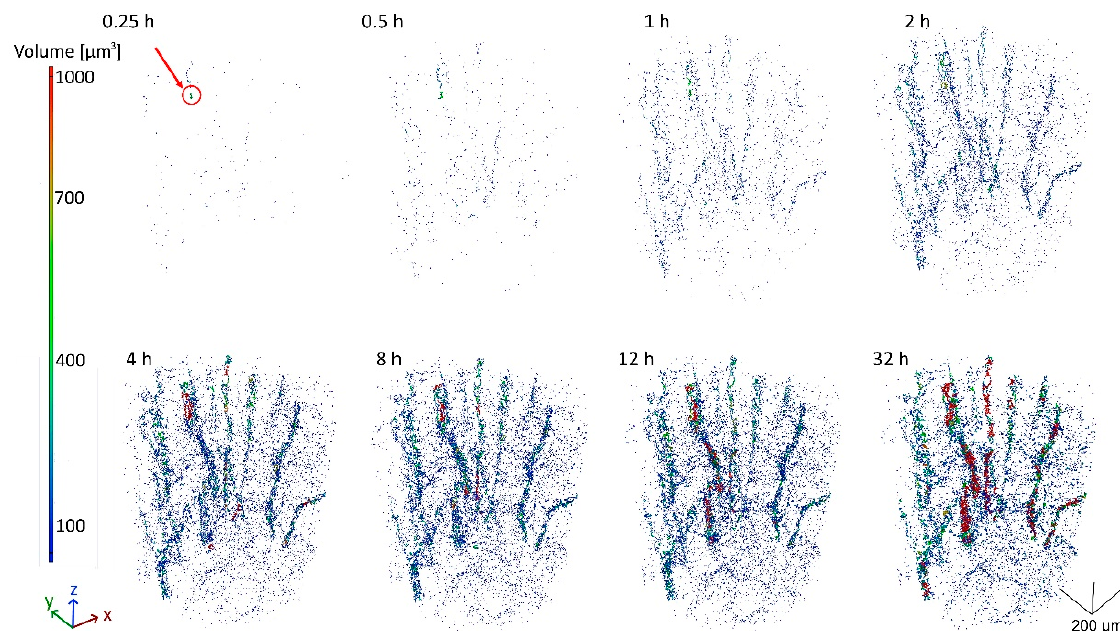
Figure 5. Evolution of Kirkendall voids (clusters) during isothermal annealing at 450 °C between 0.25 h and 32 h.